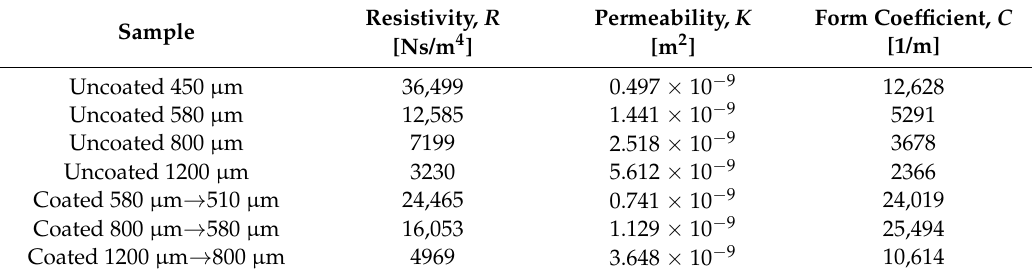
Table 2. The measured resistivity, permeability, and form coefficient for uncoated and coated metal foams.